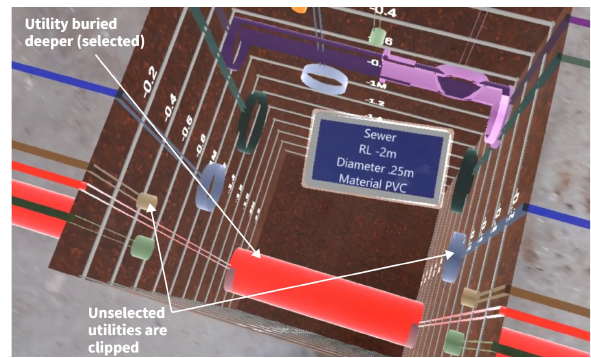
Figure 17. "X-Ray Box + Clipping